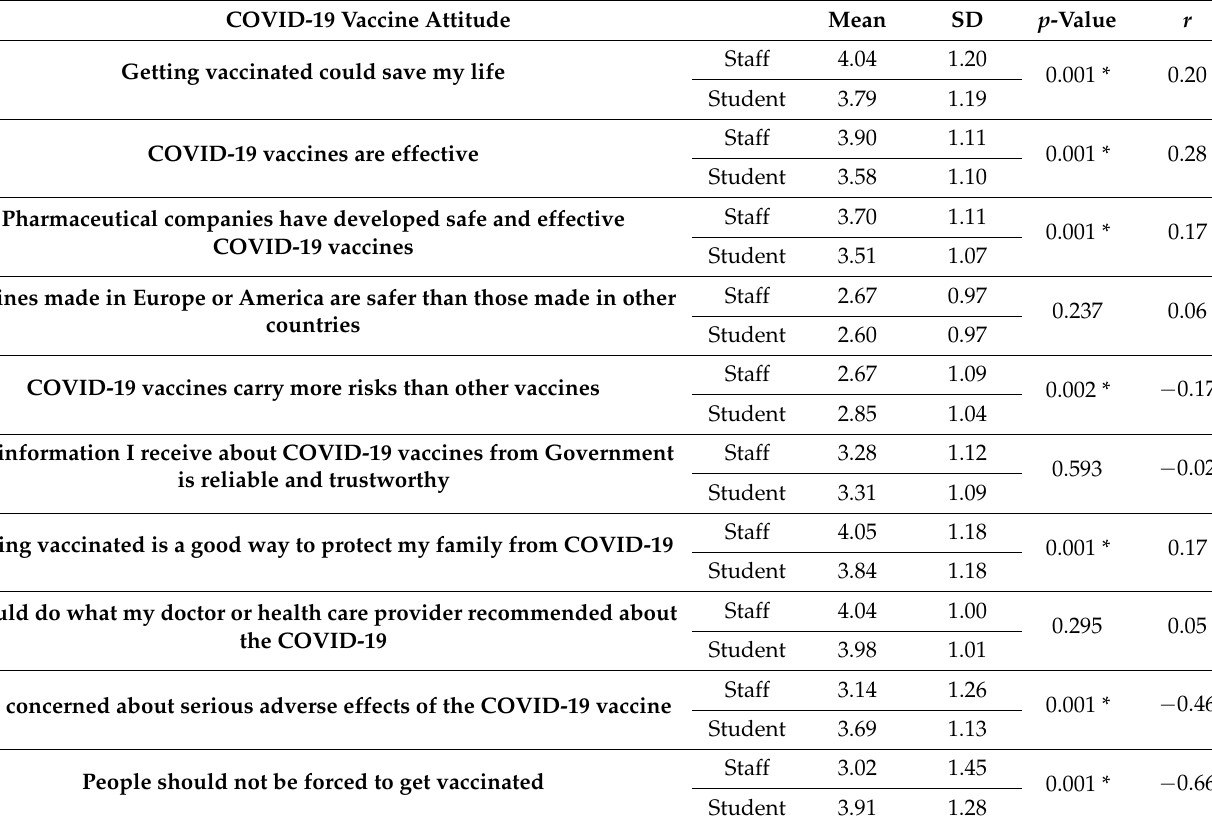
Table 5. COVID-19 vaccine